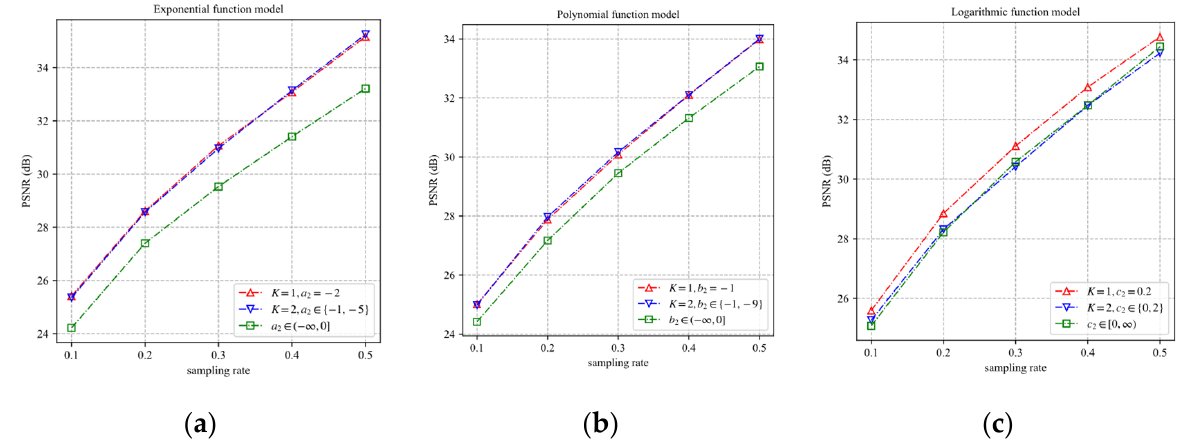
Figure 13. Average PSNR curves of the eight reconstructed images for the proposed ABCS schemes: ( a ) EFM-based scheme; ( b ) PFM-based scheme; ( c ) LFM-based scheme.